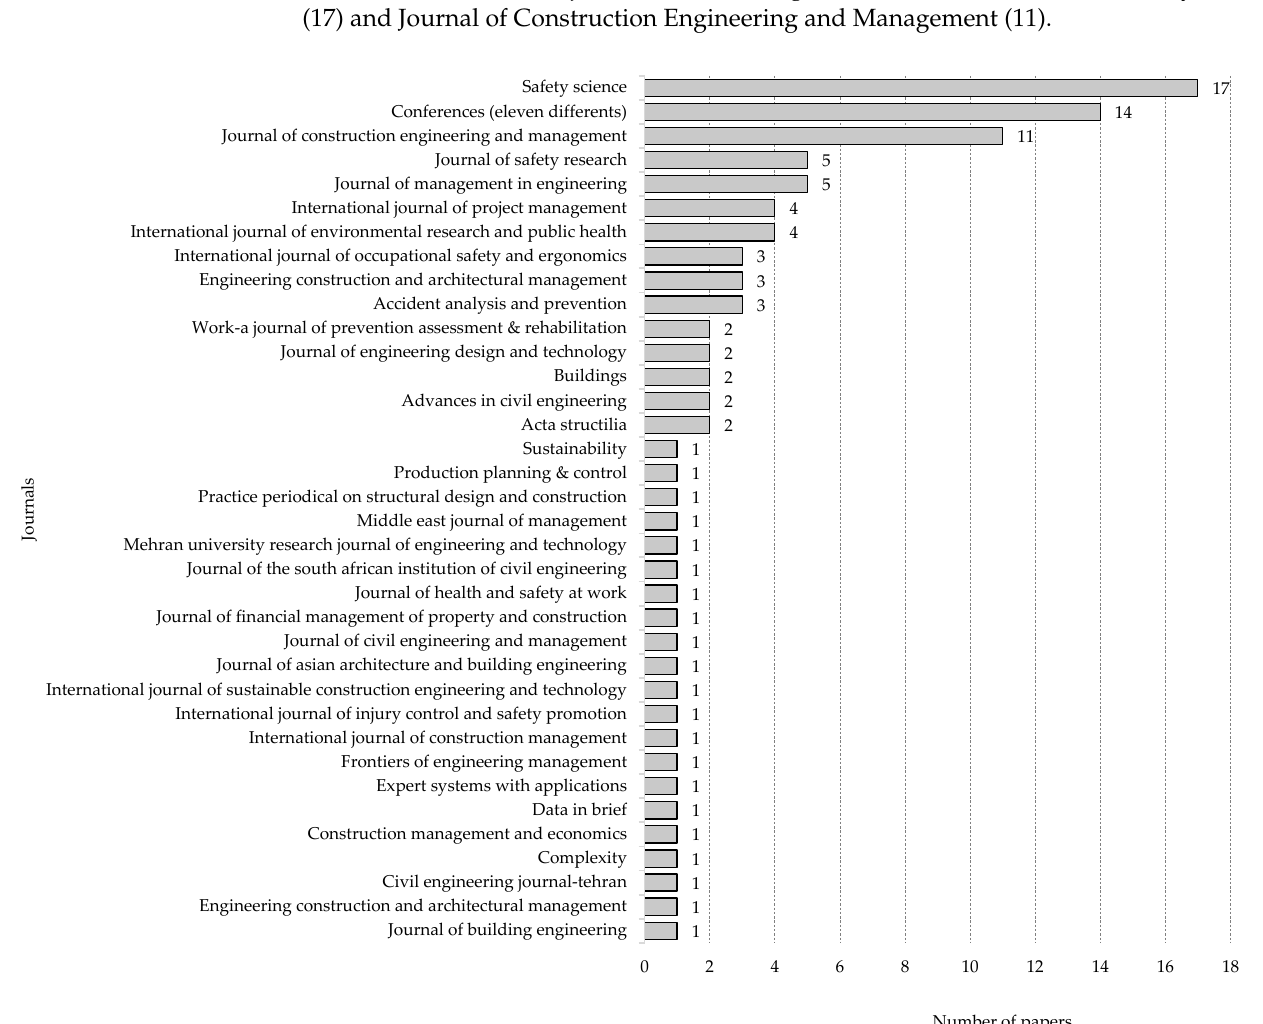
Figure 4. Numbers of papers published in the journals. Based on these 100 papers selected, 100 factors influencing safety on construction projects (fSCPs) were identified and described, and categories were established to organ- ise them. Each paper addressed various factors and aspects of interest, contributing quan- titatively and qualitatively to fulfilling the research objectives. Table 1 in the Supplemen- tary Materials contains the details of the intersection between the 100 factors identified and the 100 papers collected. However, 17 papers were identified as relevant because their results contributed more directly to the objectives of this research. The approaches to the search for factors and classifications presented in these investigations have served as input for constructing the proposal presented in this research. Some classifications names of factors and categories were considered and/or adapted for this research. Table 1 shows the title, year of publication, journal, field and a description of each study, highlighting the contributions and limitations. Table 1. Key articles’ title, year, source, field, study region and the description. Article Title